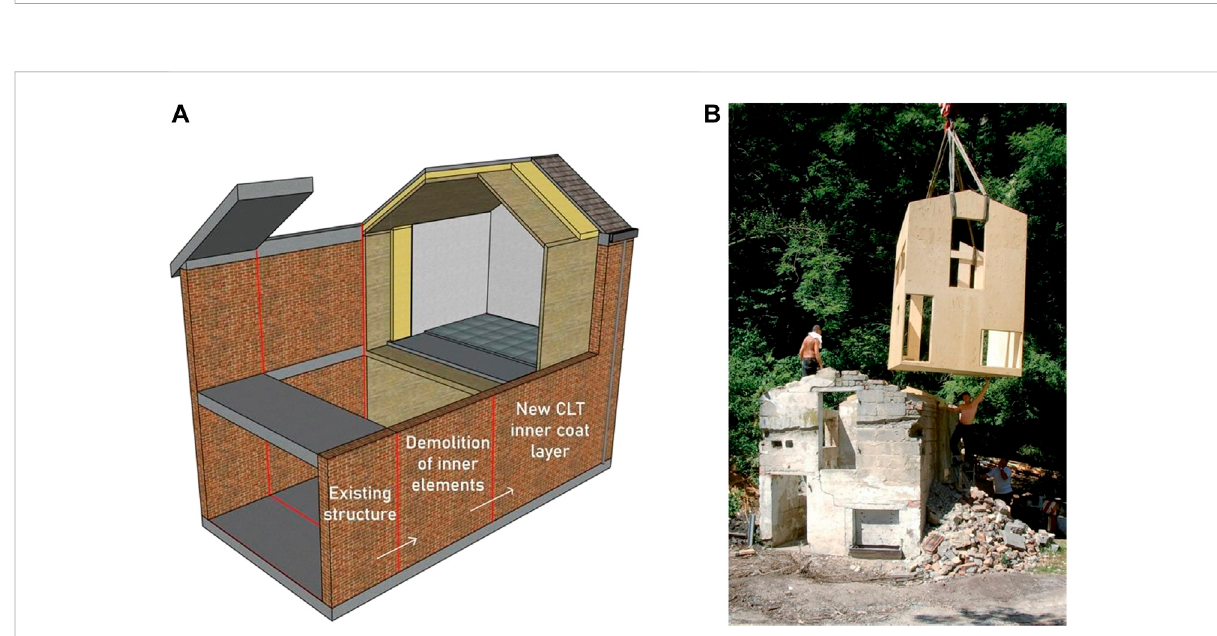
FIGURE 9 Nestedbuildingretro fi ttinginterventionthroughCLTpanels: (A) conceptualrepresentationofworkphases(Valluzzietal.,2021); (B) exampleof the insertion of the new CLT structure inside the existing envelope (Lucchini et al.,